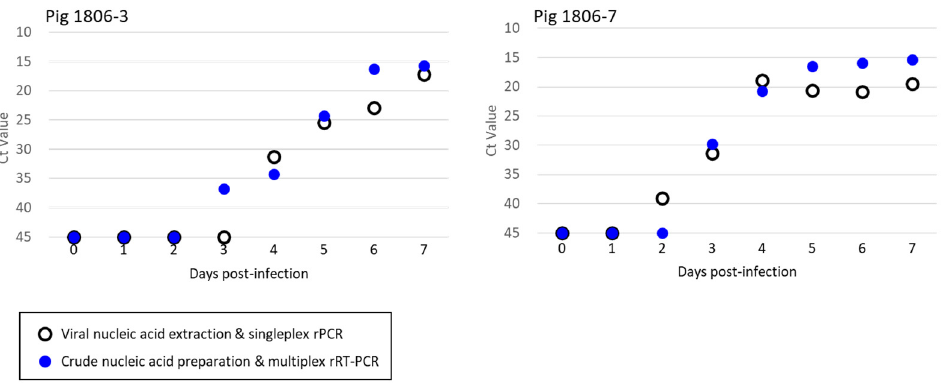
Figure 4. Representative amplification plots of the multiplex rRT-PCR. ( A ) Detection for the serum and tissue homogenate of spleen from ASFV infected wild boar. The serum and spleen were collected from experimentally infected wild boar (ID, 2002–3) and pig (ID: 2105-10) as listed in Table 1. ( B ) Detection of the serum and tissue homogenate of tonsils from wild boar suspected to be infected with CSFV. The serum and tonsil were collected from infected wild boar (ID: YN_174) and (ID: IS-633) in the field as listed in Supplemental Table S1.